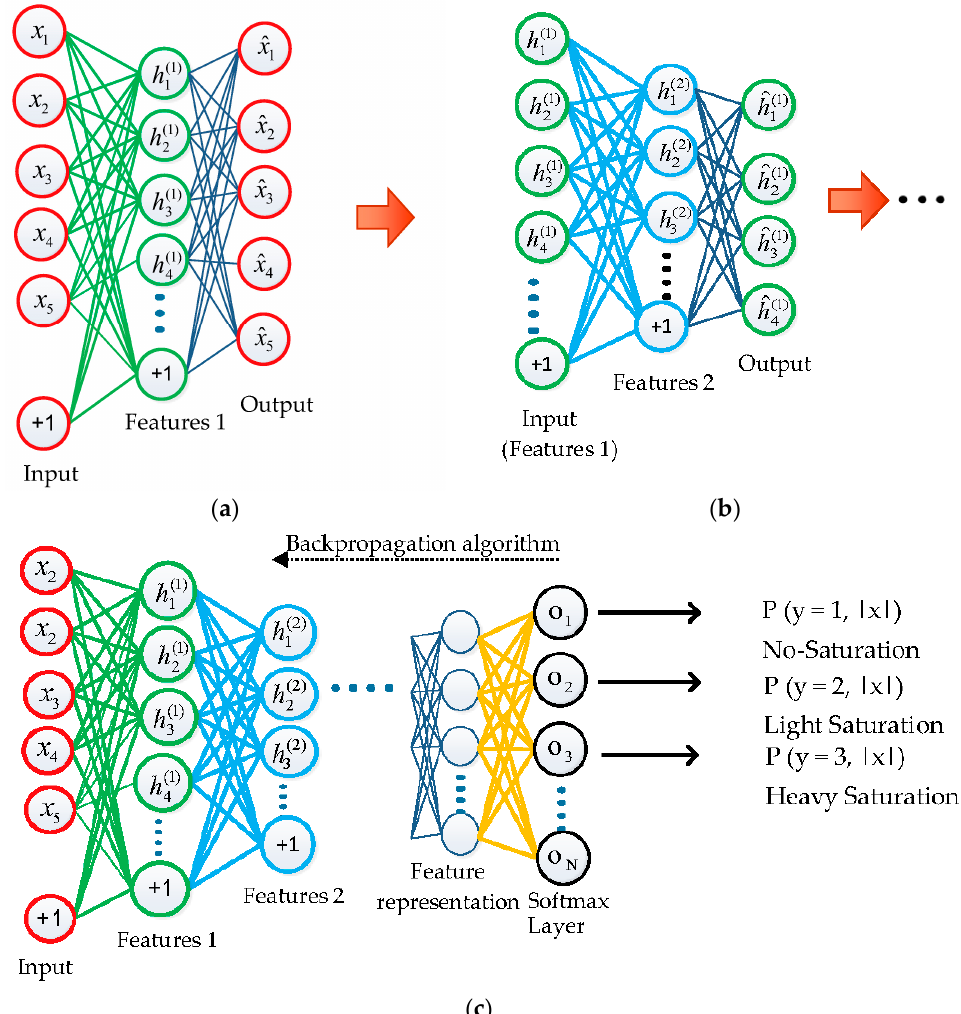
Figure 6. Layer-wise unsupervised pre-training and supervised fine-tuning strategy: ( a ) 1st stage of autoencoder Learning; ( b ) 2nd Stage of autoencoder; ( c ) Supervised fine-tuning.